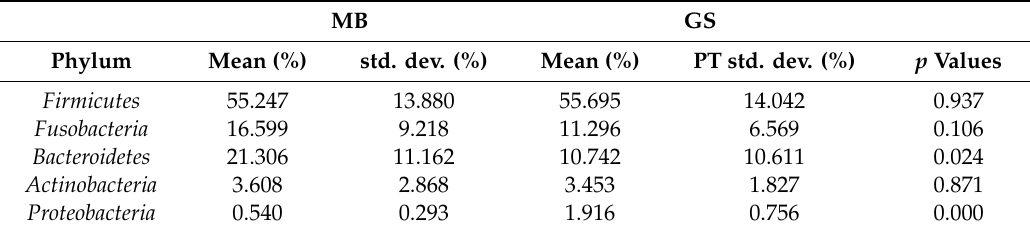
Table 1. Mean relative frequency of abundance (%) and corresponding standard deviation (SD) (%) of the phyla identified in the caeca of mixed breeds (MB) and German Shepherd (GS) dogs. The species indicated are those showing a mean relative frequency of abundance ≥ 0.1% in at least one group. p values in bold are those significantly di ff erent.